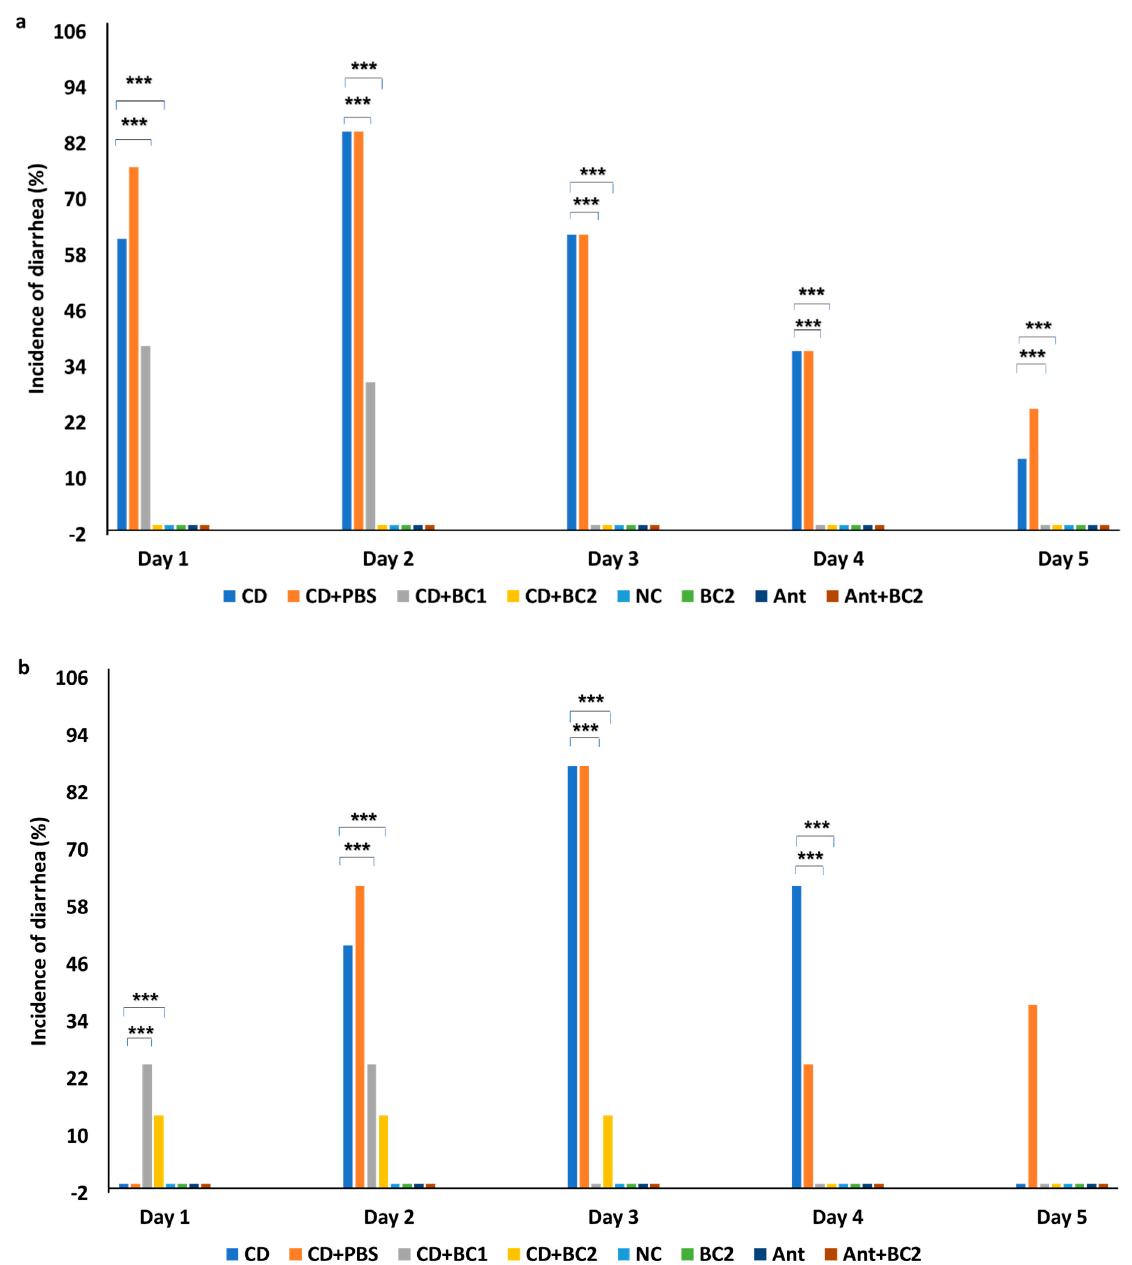
Figure 1. Effect of baicalin supplementation on the incidence of diarrhea in mice after CDI. Percentage incidence of diarrhea was recorded from 1 DPI to 5 DPI in the different treatment groups in the prophylactic BC study ( a ) therapeutic BC study ( b ). *** indicates a statistically significant difference ( p < 0.0001) relative to challenged, positive control (CD) vs. the baicalin-treated challenged mice (CD+BC1 or CD+BC2). Error bars represent SEM. Treatment groups: NC (unchallenged negative control), Ant (unchallenged antibiotic control), Ant+BC (unchallenged antibiotic + 22 mg/L BC control), BC2 (unchallenged 22 mg/L BC control), CD (Ant+ C. difficile -challenged control), CD+PBS (Ant+ C. difficile -challenged control, PBS solvent control), CD+BC1 (Ant+ CD + 11 mg/L BC), CD+BC2 (Ant+ CD + 22 mg/L